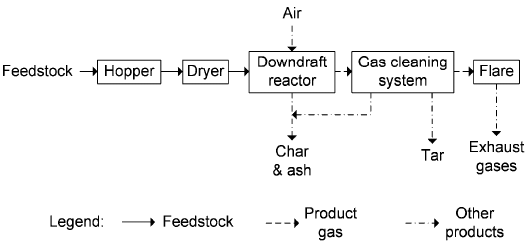
Figure 1. Block diagram for the downdraft gasifier used for the